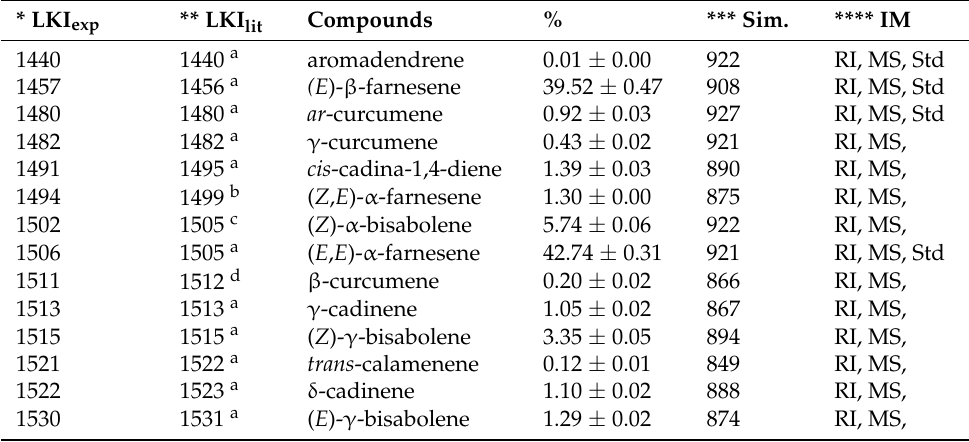
Table 1. Mean ( ± SE) chemical composition of the α -farnesene dispensers ( n = 3). * LKI Table 1. Mean (± SE) chemical composition of the α -farnesene dispensers ( n = 3) . *LKI exp